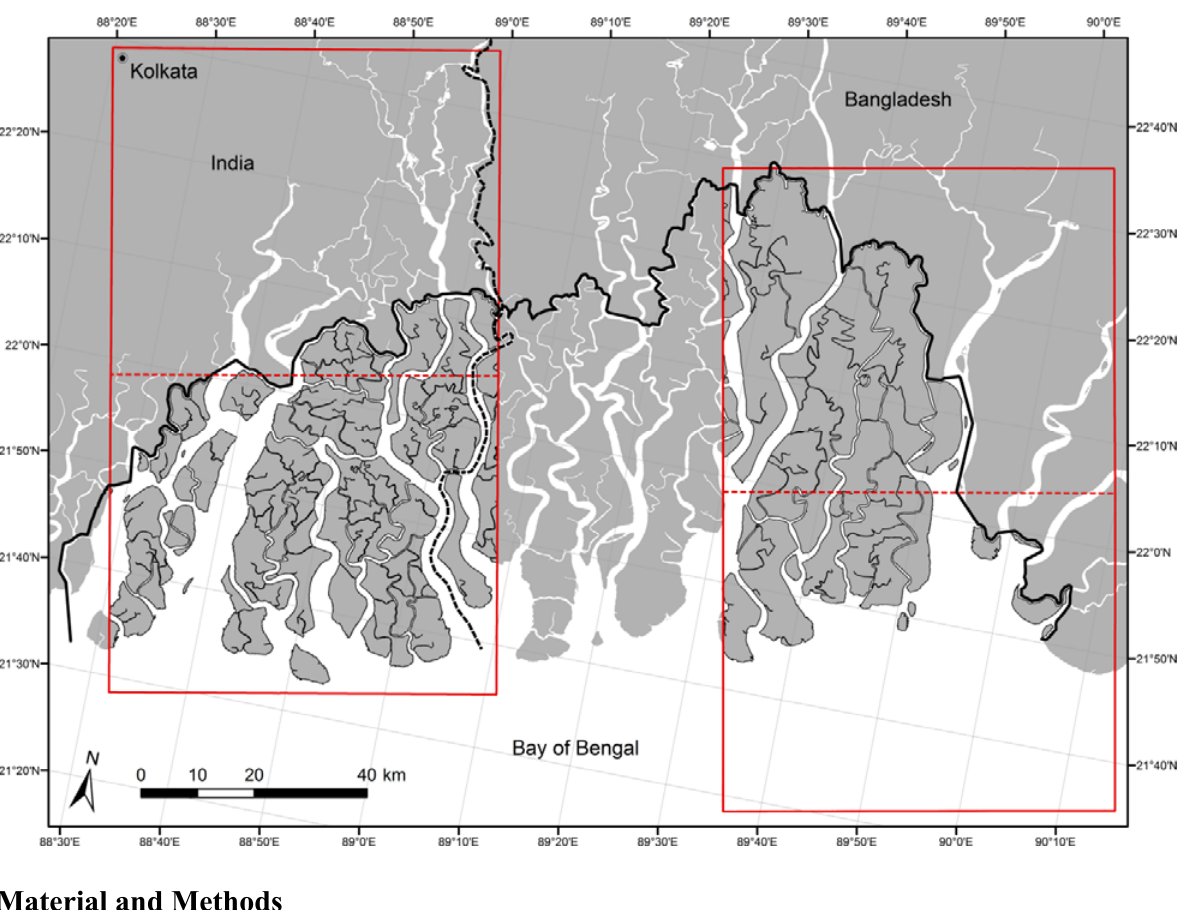
Figure 1. Map of the Sundarbans, detailing recent available PALSAR scenes. The thick black line delimits the Sundarbans, while the black dotted line represents the border between Bangladesh and India. The PALSAR data used for change detection are represented by the red boxes. These are ( a ) 2 scenes for the western part of the Sundarbans (collected on 11 July 2007 and 13 July 2008), ( b ) 2 scenes for the Eastern part of the Sundarbans (collected on 7 June 2007 and 12 June 2009). Each scene is composed of two tiles; the red dotted line represents the